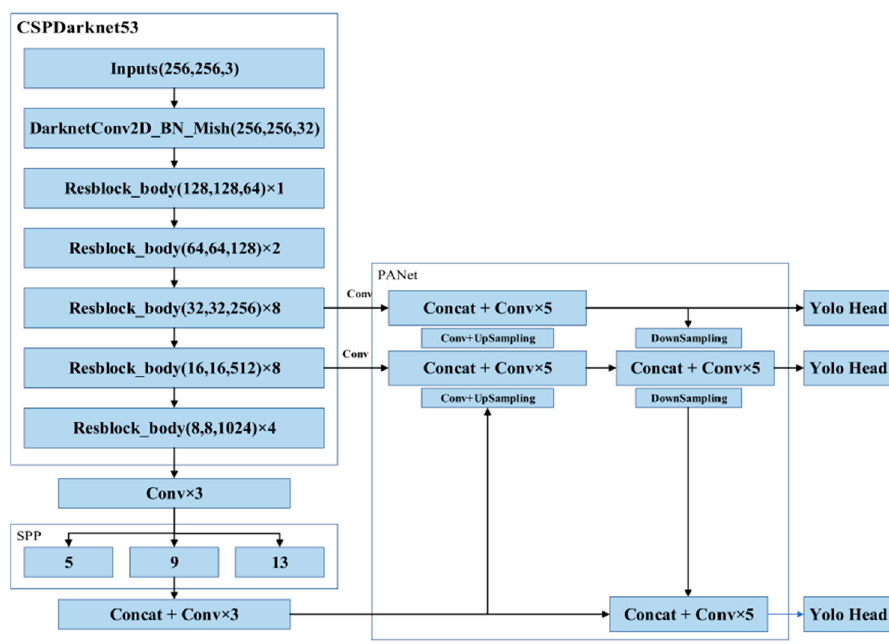
Figure 7. YOLOv4 model architecture